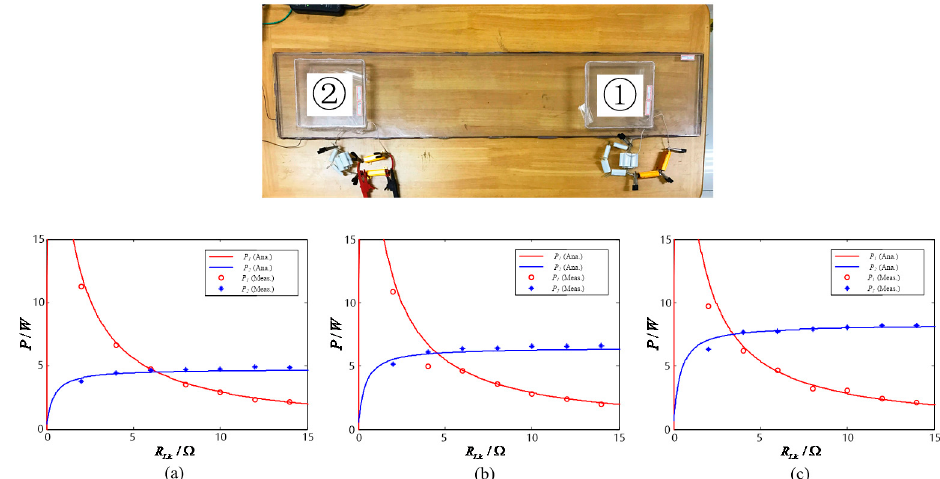
Figure 9. The experimental curve of the receiving power versus load resistance variation according to di ff erent initial state while n = 2: ( a ) P 0 = 4.5 W; ( b ) P 0 = 6 W; ( c ) P 0 = 7.5 W.